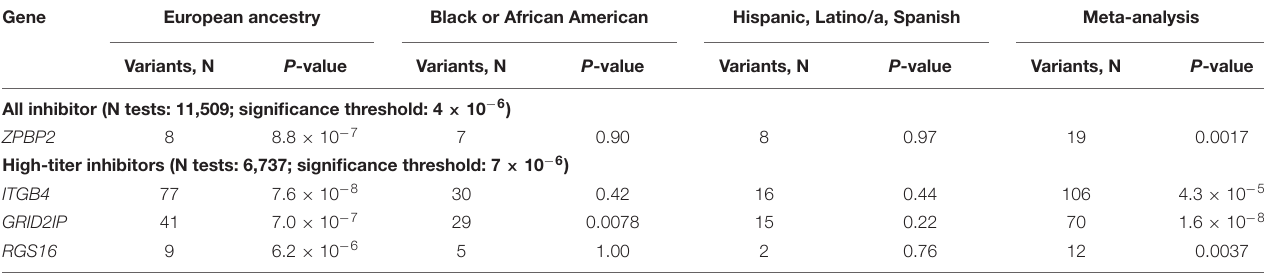
TABLE 3 | Significant genes associated with inhibitors by variant-aggregation tests. Gene European ancestry Black or African American Hispanic, Latino/a, Spanish